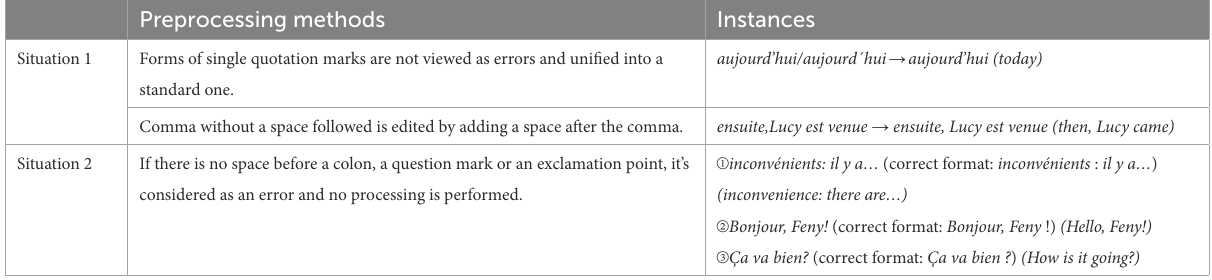
TABLE 1 Dictation texts preprocessing concerning punctuations and spaces. Preprocessing